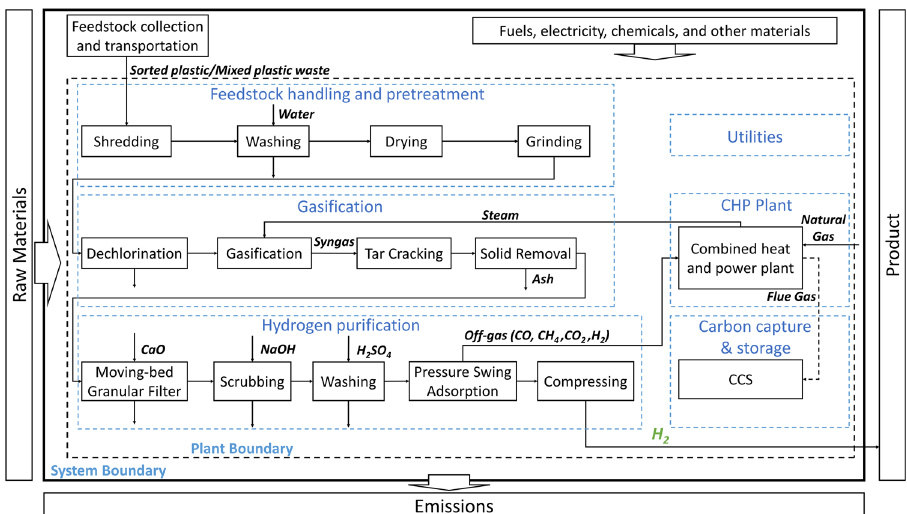
Fig. 1 System boundary of Life Cycle Assessment and fl ow diagram of the plant. The fl ow diagram inside the plant boundary includes fi ve main areas, including feedstock handling and pretreatment, gasi fi cation, hydrogen puri fi cation, combined heat and power (CHP) plant, and utilities, along with carbon capture and storage (CCS) for scenario